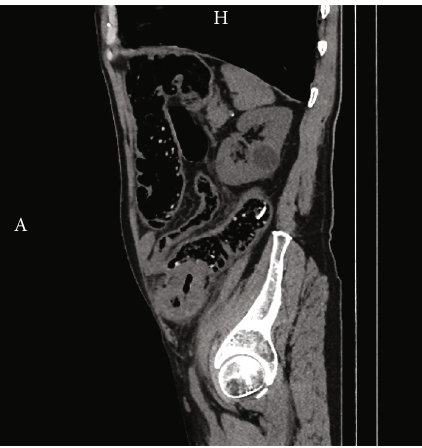
Figure 1: The tumor in the sigmoid fi xated to the abdominal wall seen on CT in lateral